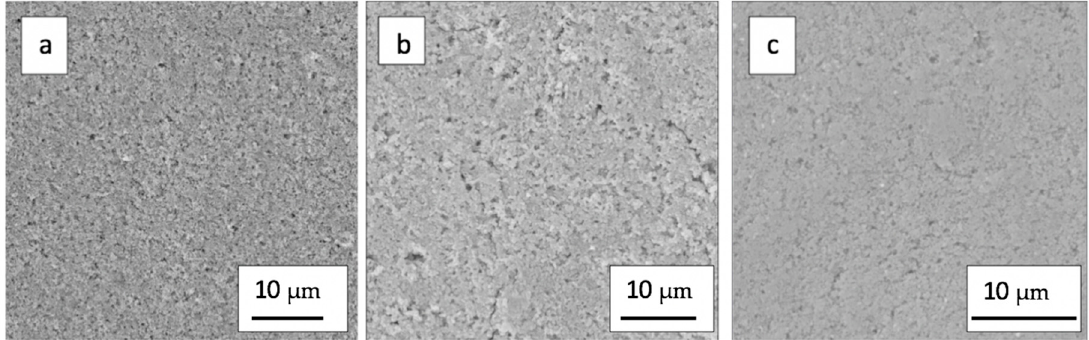
Figure 11. SEM images of the surface of the nanocomposite thin films with ZnO volume fractions of ( a ) 0.4, ( b ) 0.6, and ( c ) 0.7.